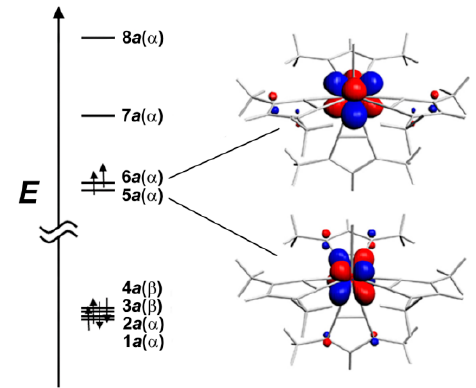
Figure 30. DFT frontier energy level diagram and MOs for [(Me 2 Pz) 4 UCl] - . The Me 2 Pz- ligands are shown as skeletal representations, and the U-Cl axis is oriented vertically (reprinted with permission from [122], American Chemical Society, 2007).